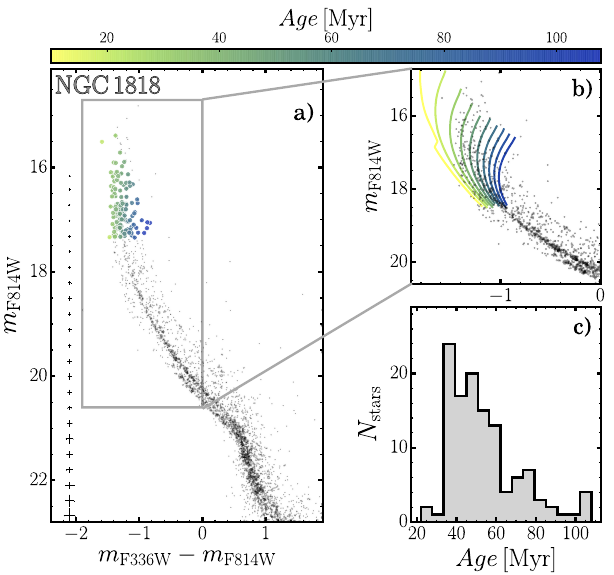
Fig. 2 | Extended main-sequence turn-off in NGC1818. a Colour – magnitude dia- gram of NGC1818 from optical and ultraviolet magnitudes, i.e. WFC3/UVIS F814W and F336W. turn-off stars are colour-coded according to their inferred ages, as indicated in the top colourbar. Photometric uncertainties, shown on the left, are computed from arti fi cial star tests, as discussed in the ‘ Methods ’ section, subsec- tion arti fi cialstars. b Zoom of the turn-offregion. The solid lines superimposed on theCMDarenon-rotatingisochrones,computedwiththePadovamodels,withages ranging from 10 to 100Myr in steps of 10Myr. c Age distribution of turn-off stars derived from the isochrone